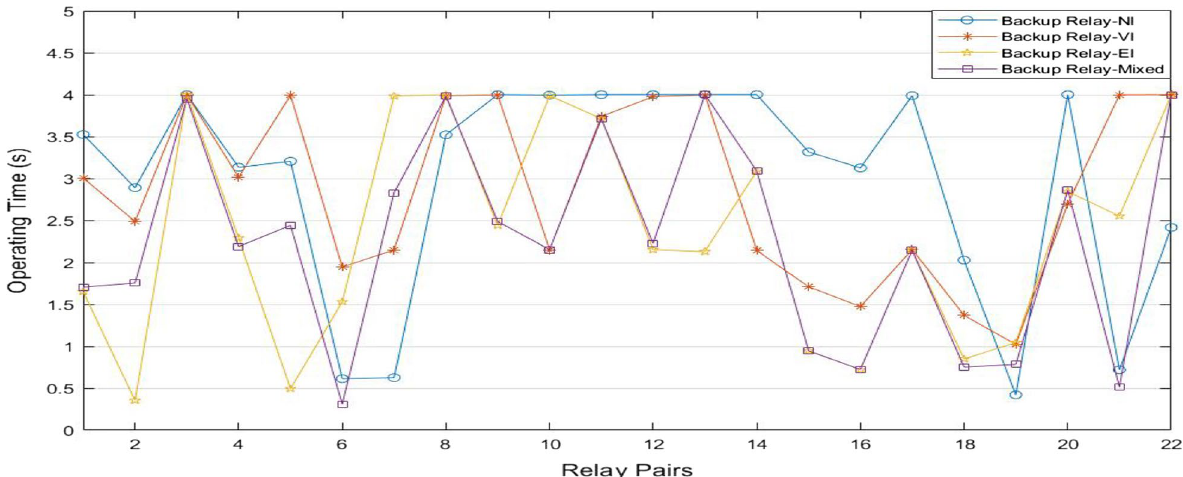
Fig. 7 Backup relay operating time having NI, VI, EI and mixed characteristics in grid- connected